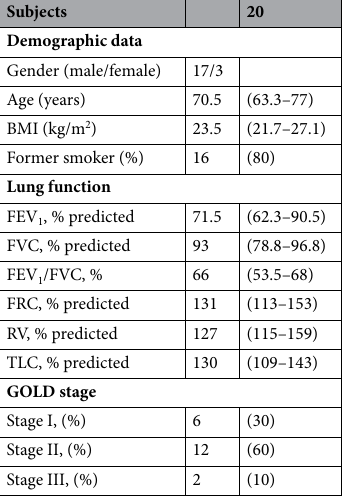
Table 1. Participant characteristics. Data are presented as median (IQR) or number (%). BMI body mass index,